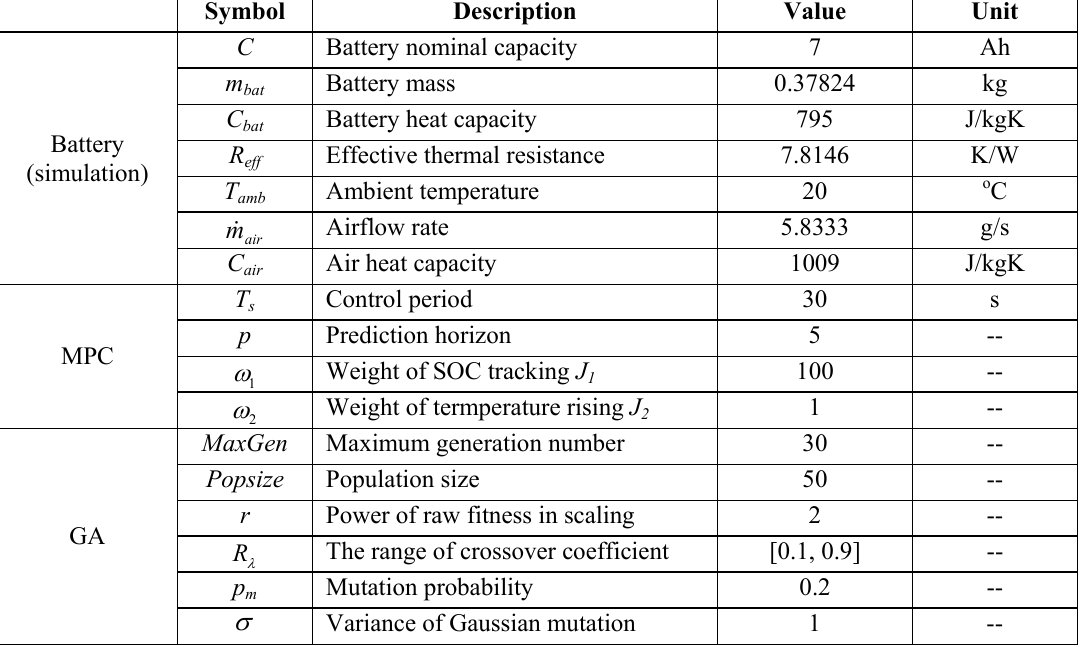
Table 1. Parameters setting in the simulation and